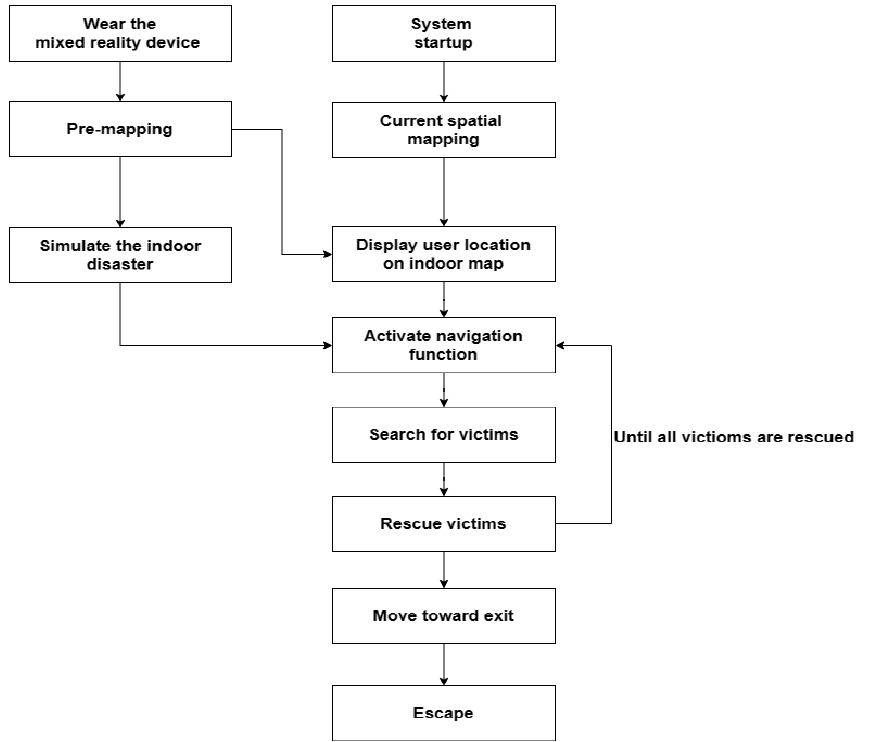
Figure 5. Flowchart of the MR system simulating indoor disaster rescue.